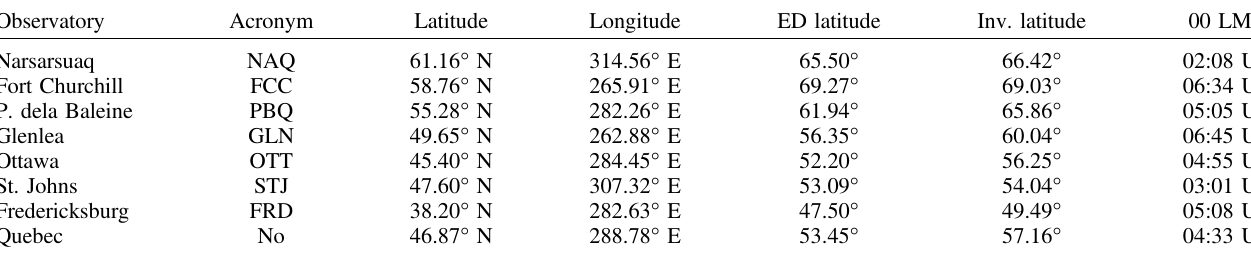
Table 3. Quebec location and relevant magnetic observatories in and around Canada. Observatory Acronym